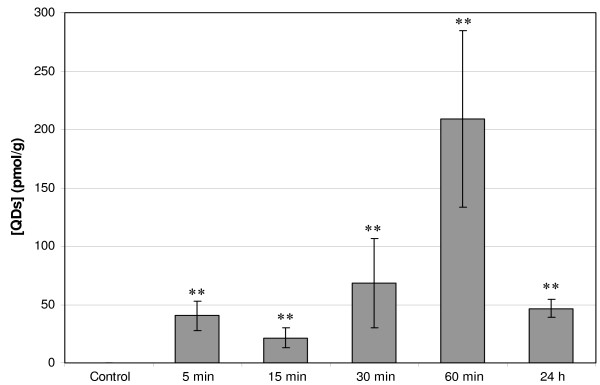
Concentration of QDs (pmol/g) detected in ALN. 20 pmol were injected subcutaneously in the distal part of the right anterior paw of nude mice. Mice were sacrificed at 5, 15, 30, 60 min and 24 h after injection. Concentration of QDs (pmol/g) was detected in ALN by spectrofluorometry after chemical extraction. Error bars represent SEM, values marked with asterisk were significantly different from control (P < 0.01). ALN: Axillary Lymph Node; QDs: Quantum Dots.